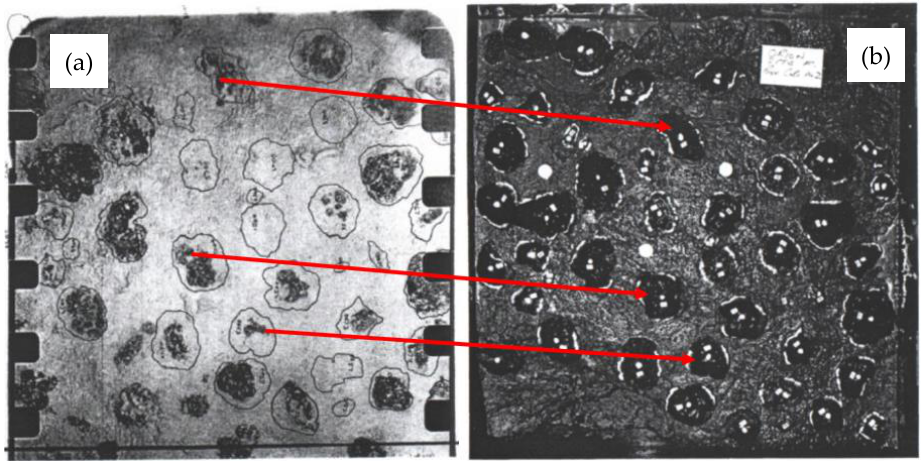
Figure 21. Seabed (a) and box-core (b) photograph pair in an area with a high degree of sediment cover. After Felix [66]. Figure 21. Seabed ( a ) and box-core ( b ) photograph pair in an area with a high degree of sediment cover. After Felix